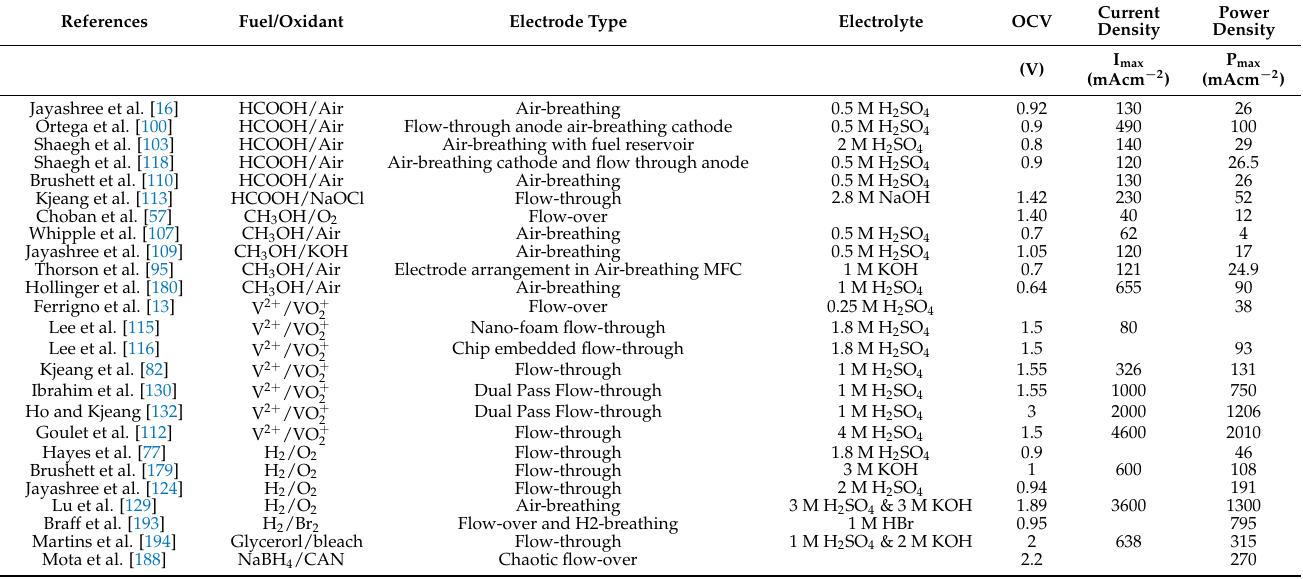
Table 4. Performance of MMFCs with different